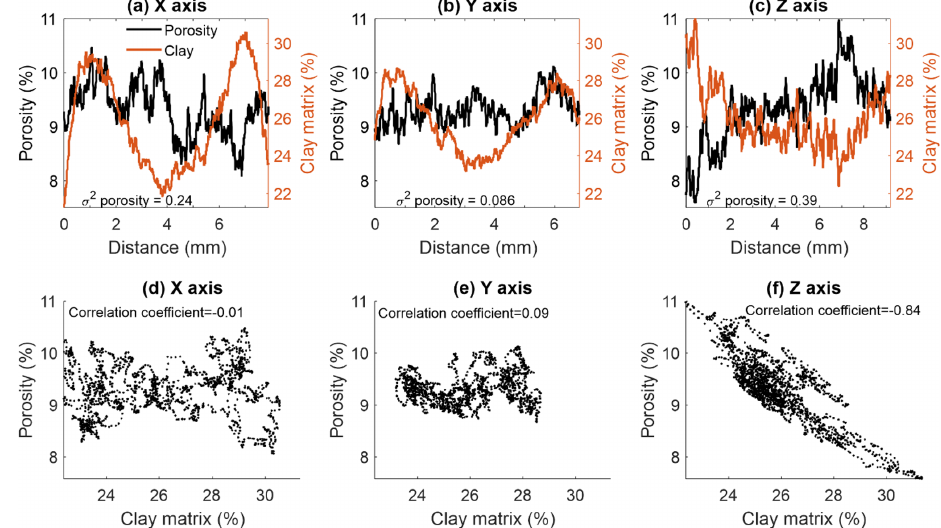
Figure 13. Correlation between porosity and clay in S2. Porosity and clay profiles (left and right y axes, respectively) in slices of S2 evaluated in the (a) x direction, (b) y direction and (c) z direction. Scatterplots of clay content and porosity in S2 in the (d) x direction, (e) y direction and (f) z direction. Investigated maximal segmented volume size is 7 . 9 × 6 . 8 × 9 . 2mm 3 (see text for more details). Table 3. Porosity losses in S1 and S3 over the course of applying the extended computational workflow (Fig. 2). Sample